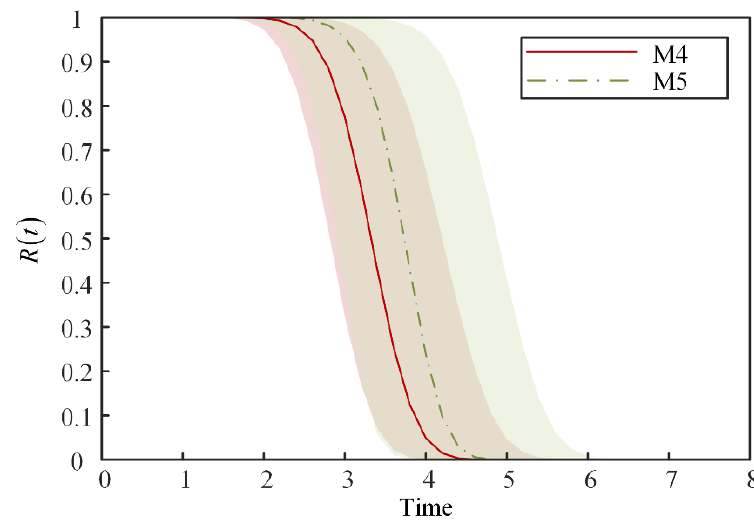
Figure 6. Reliability confidence intervals for different models.